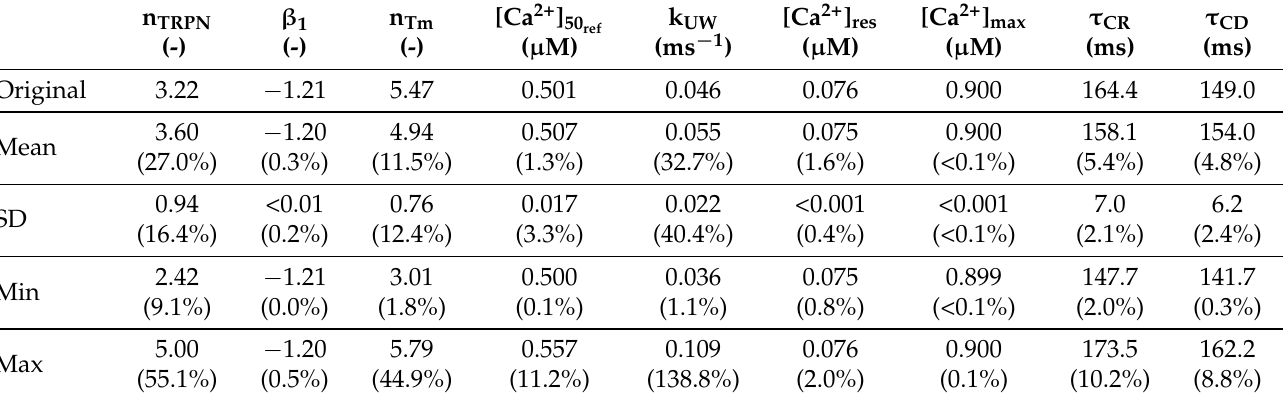
Table 5. Results of the clinical data uncertainty robustness analysis for the patient case 02-CoA. Esti- mated model parameter values of the second step of the active mechanics personalisation approach are given. The original values produced by the default initial guesses are listed in the first row and means (M), standard deviations (SD), minima (Min), and maxima (Max) of ten samples are listed in the subsequent rows. Means, standard deviations, minima, and maxima of the relative differences are given in brackets below.